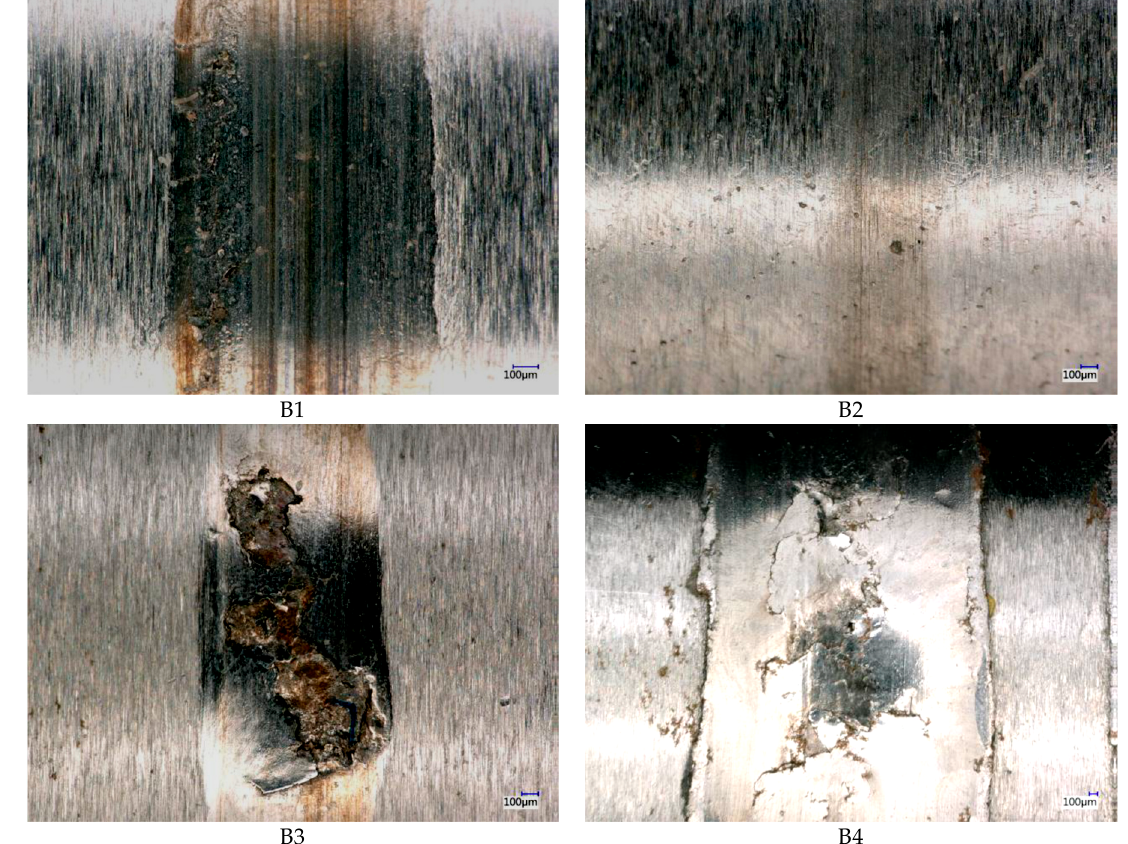
Figure 10. Macrostructure of surfacing layers at the wear point (19 kg).